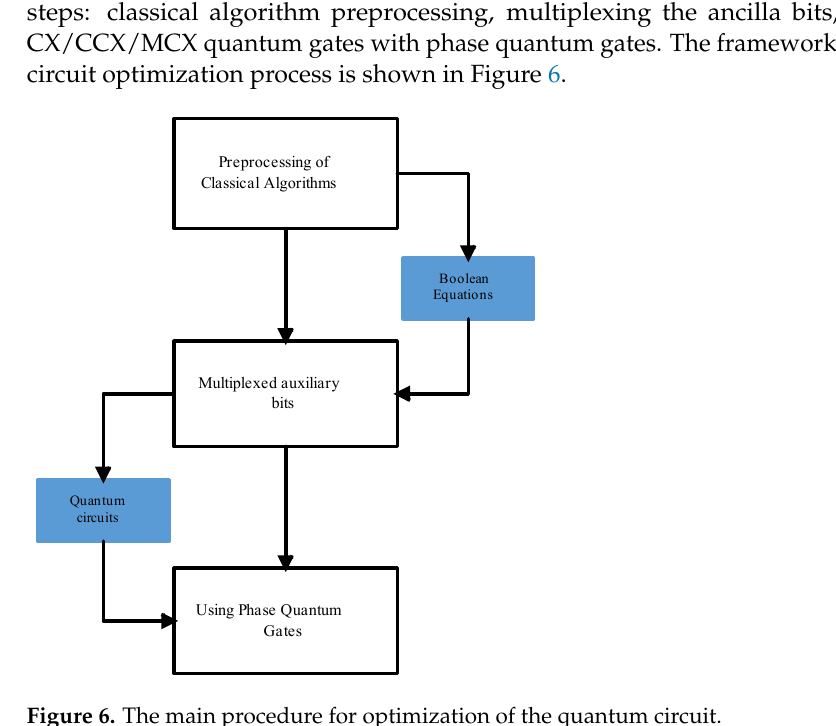
Figure 6. The main procedure for optimization of the quantum circuit.